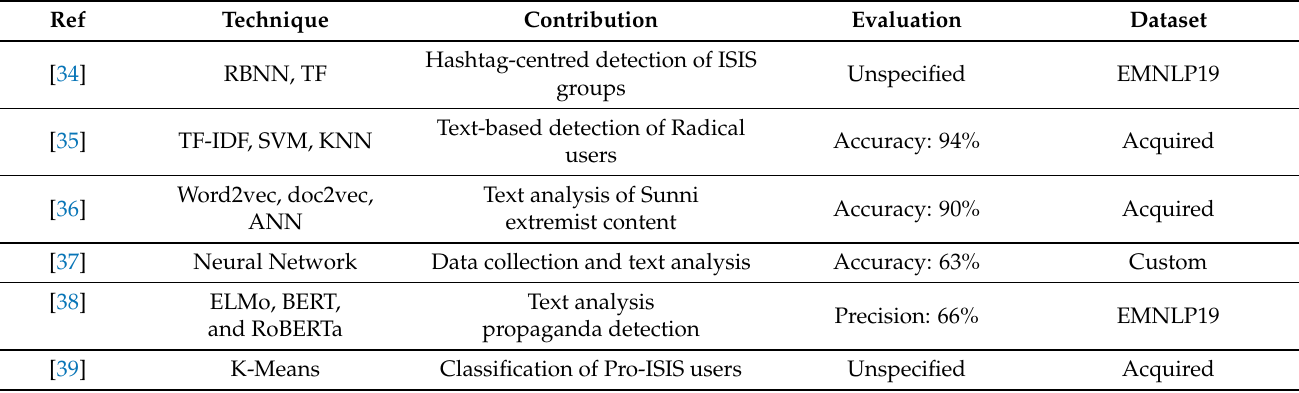
Table 2. Mixed code related